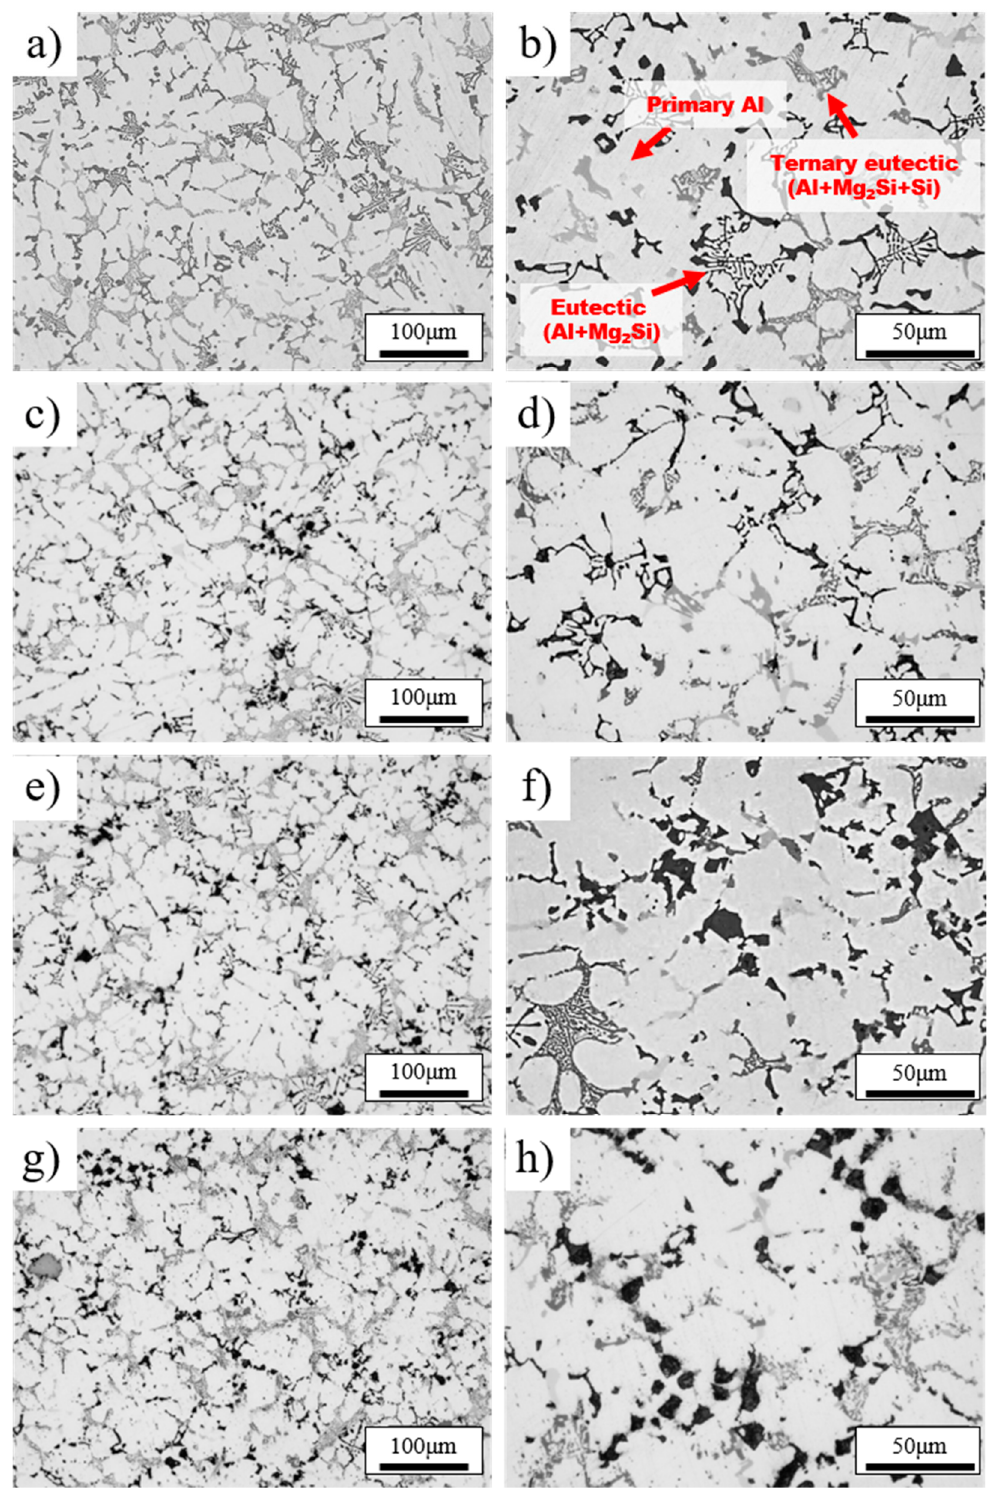
Figure 5. Optical microscope images of the Al-8Zn-6Si-4Mg-2Cu alloys: ( a , b ) no Ti, ( c , d ) 0.1 wt.% Ti, ( e , f ) 0.5 wt.% Ti, ( g , h ) 1 wt.% Ti.